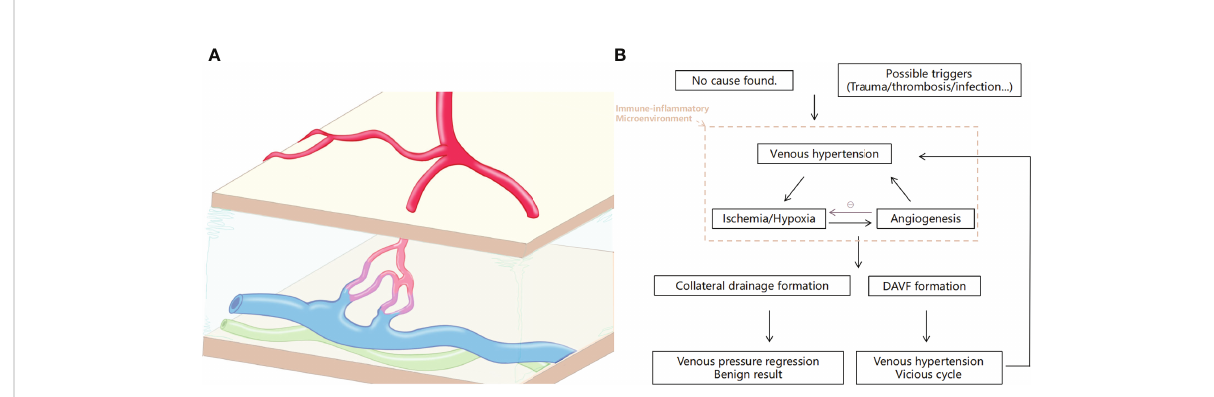
FIGURE 4 Illustration of the dural arteriovenous fi stula (DAVF) and the pathological process of the disease. (A) Schematic of DAVF that displayed the abnormal vascular architecture of the dura involving arterial feeders, draining veins, and accompanying lymphatic vessels. (B) Brief diagram of the pathophysiological process of DAVF occurrence and